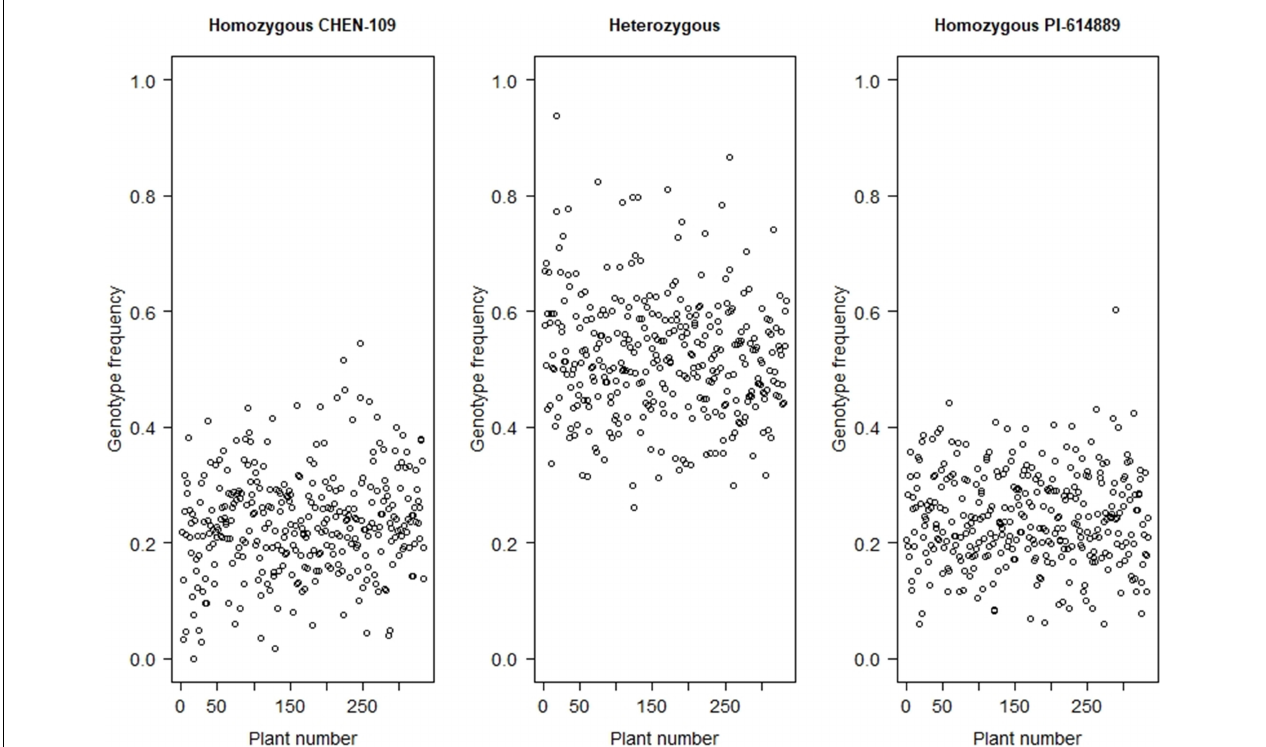
FIGURE 2 | Frequency distribution of the homozygous genotype from the parent CHEN-109, the homozygous genotype from the parent PI-614889, and heterozygous genotype, for each of the F 2